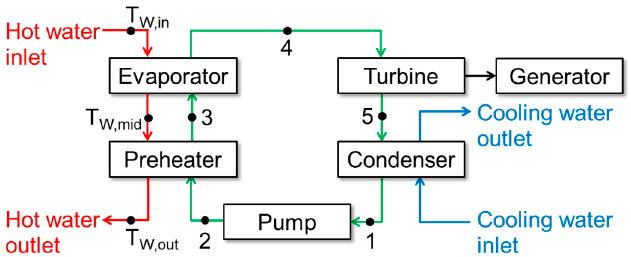
Figure 1. Schematic of the studied organic Rankine cycle (ORC) system.